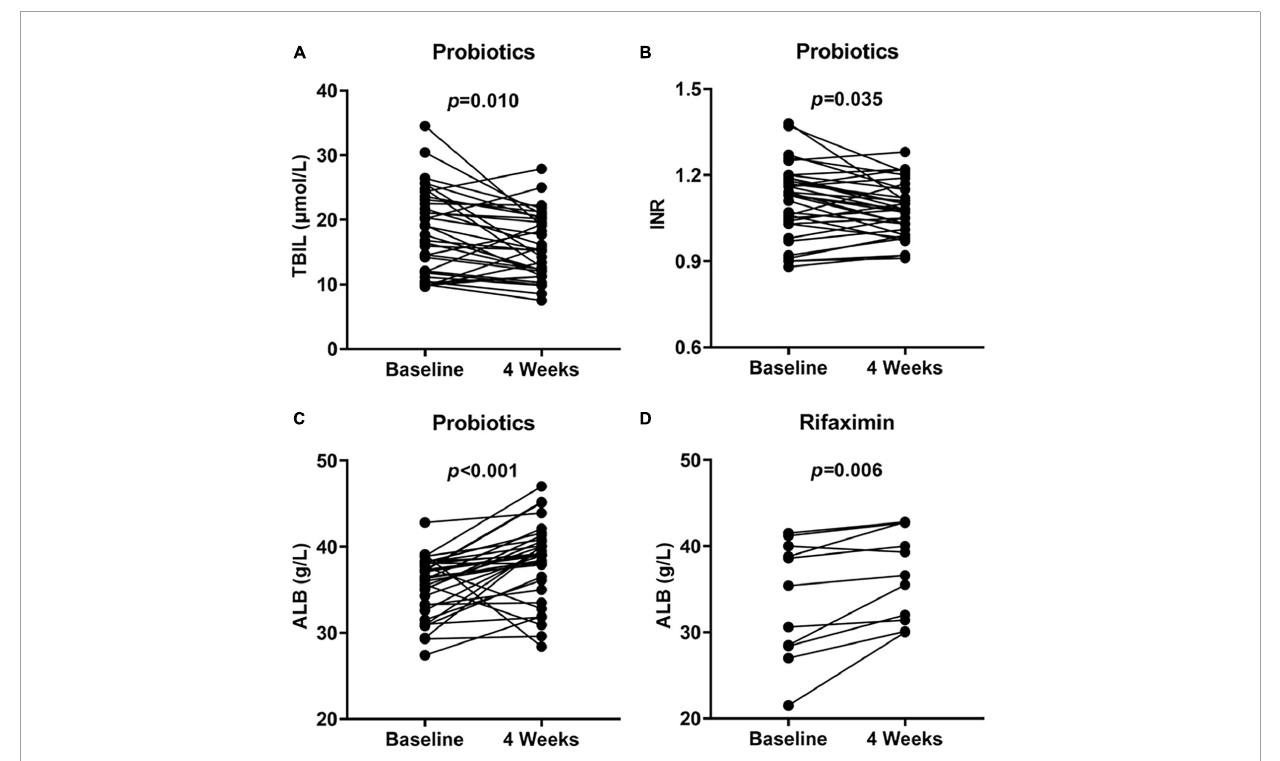
FIGURE2 Hematological indexes at baseline and 4 weeks showed significant improvement. TBIL (A) , INR (B) , and ALB (C) performance at baseline and 4 weeks in probiotics group and ALB (D) performance at baseline and 4 weeks in rifaximin group. TBIL, total bilirubin; INR, international normalized ratio; ALB, serum